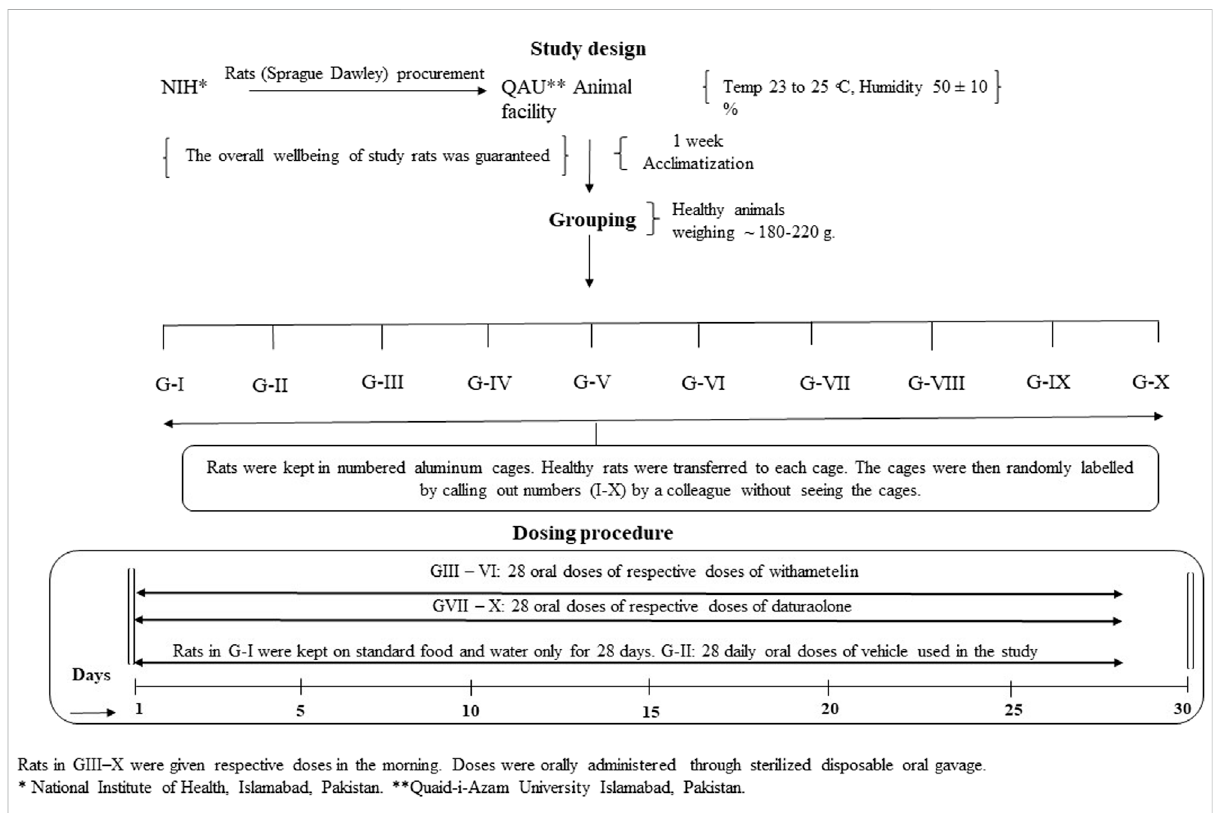
FIGURE 1 The experimental design of 28-days in vivo toxicity evaluation performed in Sprague Dawley